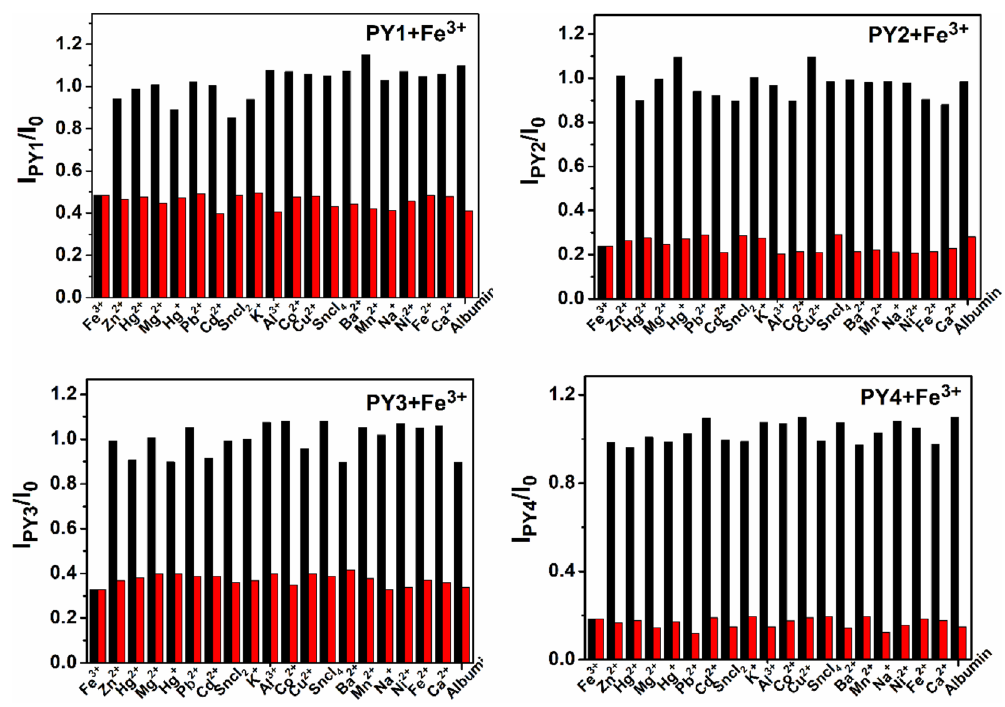
Fig. 6 Fluorescence response of polymeric probes (1 µM) to other metal ions (10 µM) and bovine serum albumin (0.1 mg/mL) in the pres- ence of Fe 3+ . a PY1, b PY2, c PY3, and d